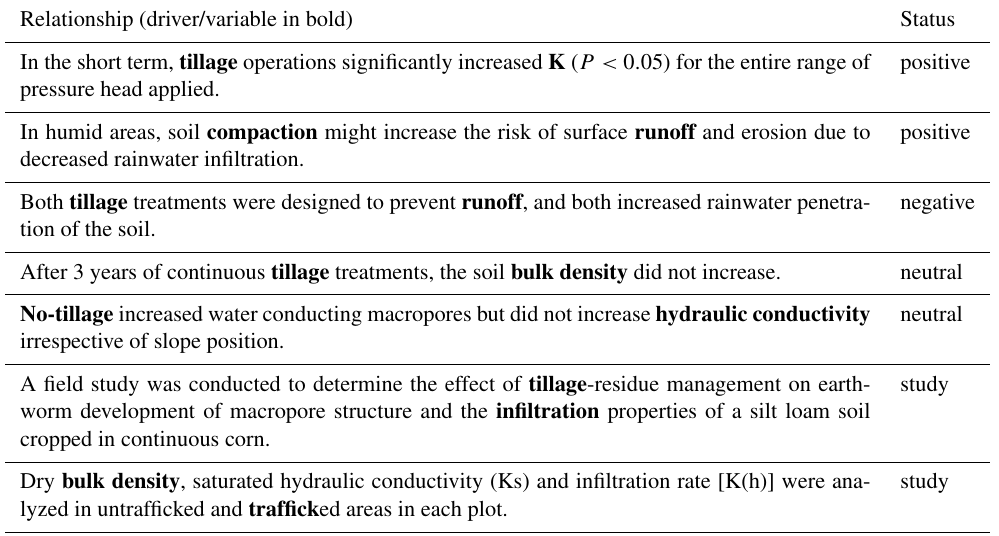
Table 2. Examples of relationships identified and their corresponding classified labels. Note that the modifiers present in the noun chunk (e.g., “conservation tillage” or “zero tillage”) and the negation in the sentence were taken into account in the status of the relationship. Some sentences contain multiple driver–variable pairs and, hence, multiple relationships. In such cases, only one of the two was indicated in the table below (but all were considered in the